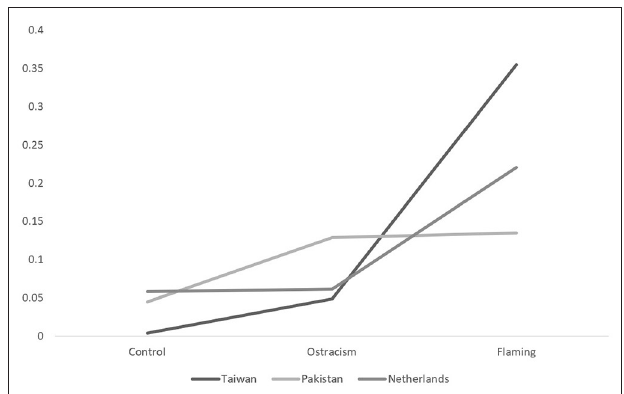
FIGURE 5 | The interaction between nationality and trolling type for